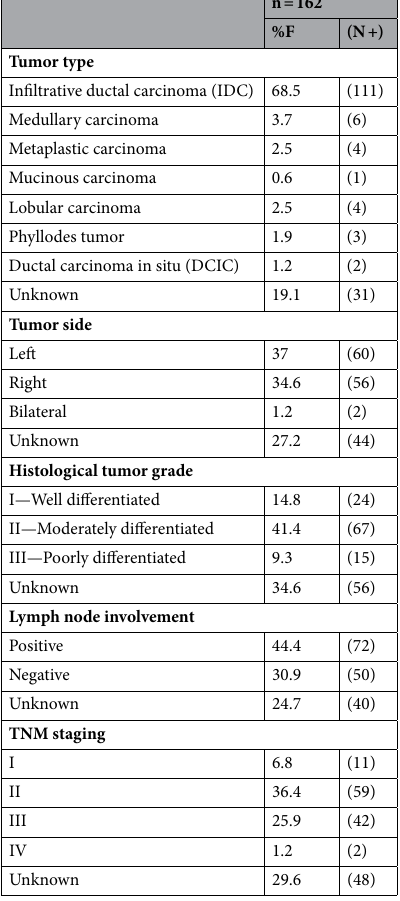
Table 3. Clinicopathological characterestics of patients with breast